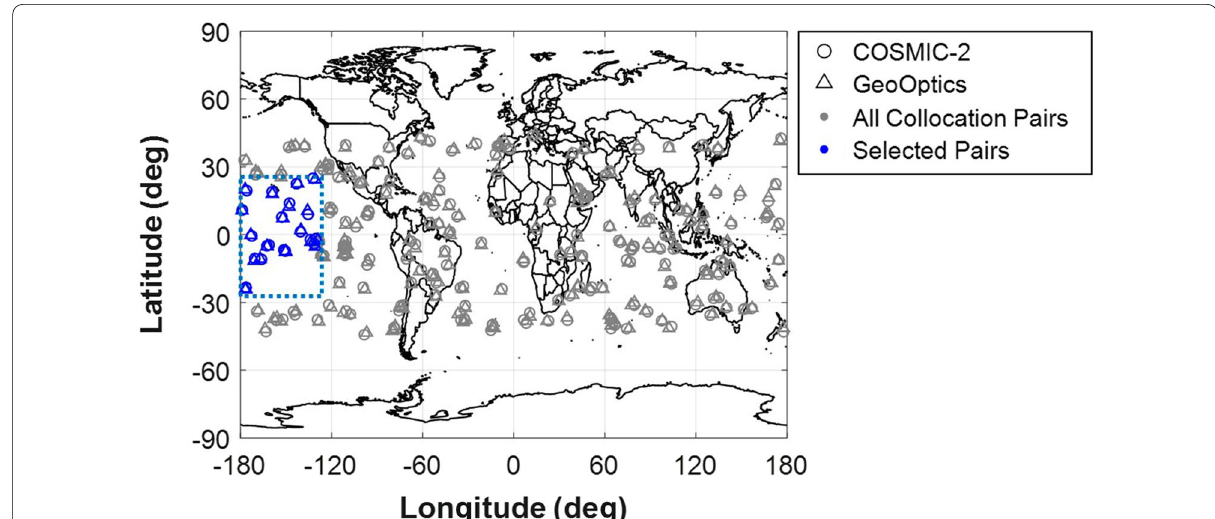
Fig. 8 COSMIC-2 (circles) and GeoOptics (triangles) collocation points during June 1st, 2021. Selected 20 pairs are indicated with blue markers within the box with light-blue dashed